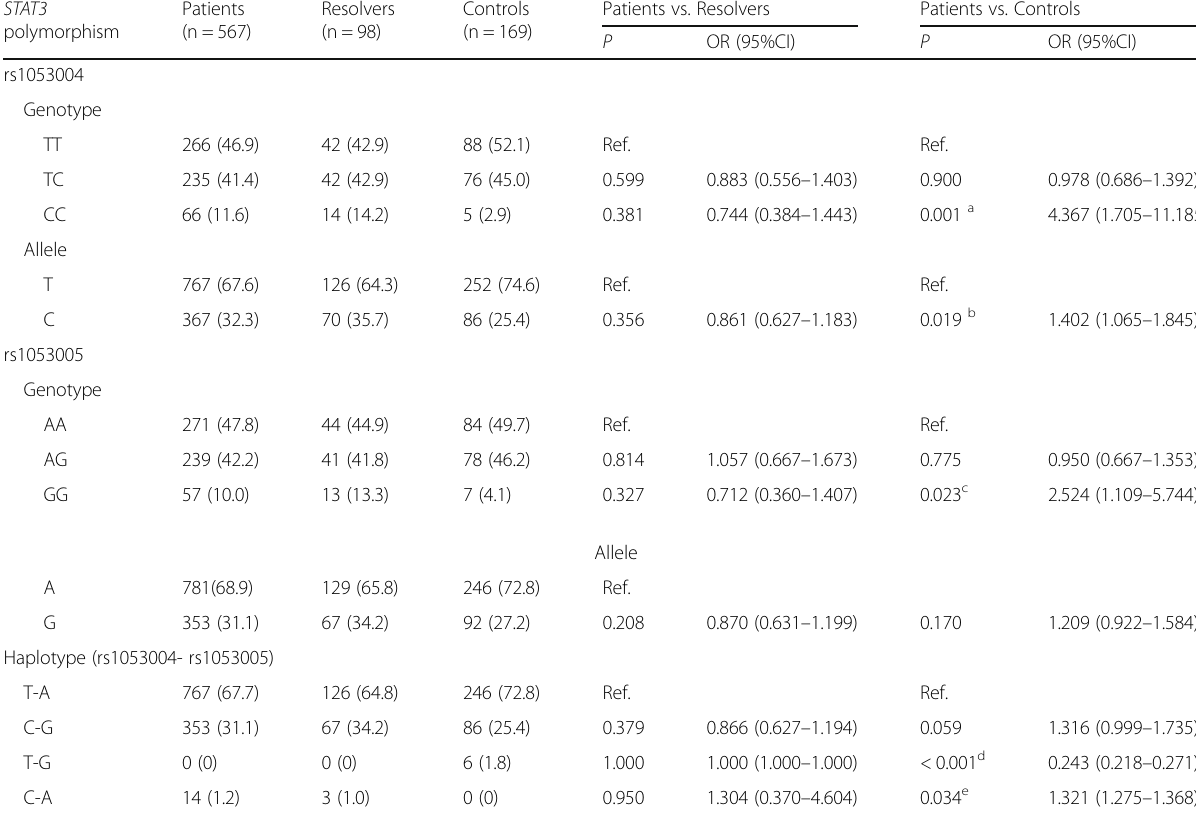
Table 2 Genotype, allele and haplotype frequencies of STAT3 rs1053004 and rs1053005 polymorphisms in patients with chronic hepatitis B virus (HBV) infection, HBV infection resolvers and healthy